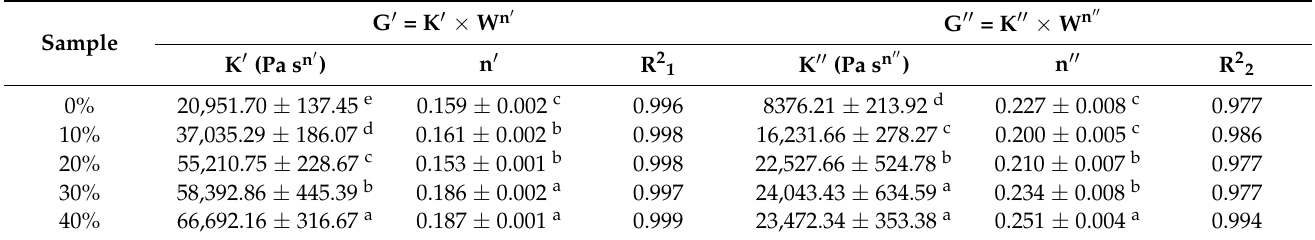
Table 5. Effect of different levels of GBP on power-law model parameters in dough frequency scan tests.